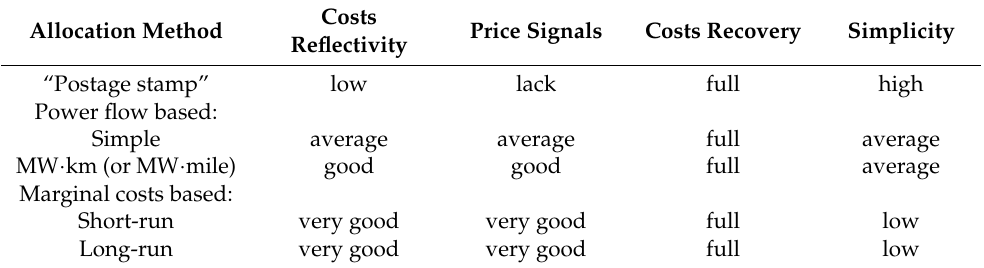
Table 1. General assessment of the fulfillment of requirements for the transmission charge for various fixed costs allocation